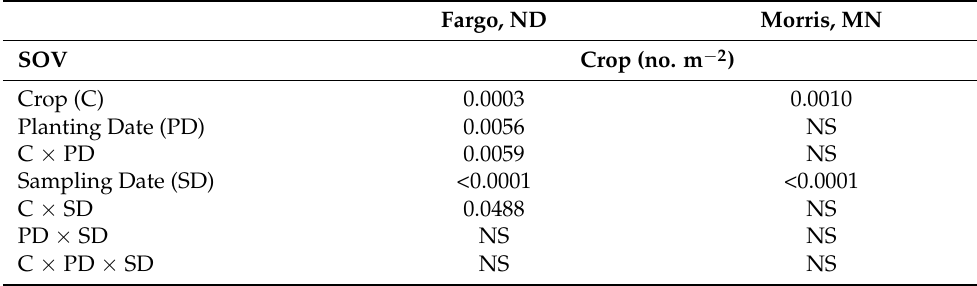
Table 1. ANOVA table showing level of significance ( p -values) for crop counts (no. m − 2 ) at Fargo, ND and Morris, MN field